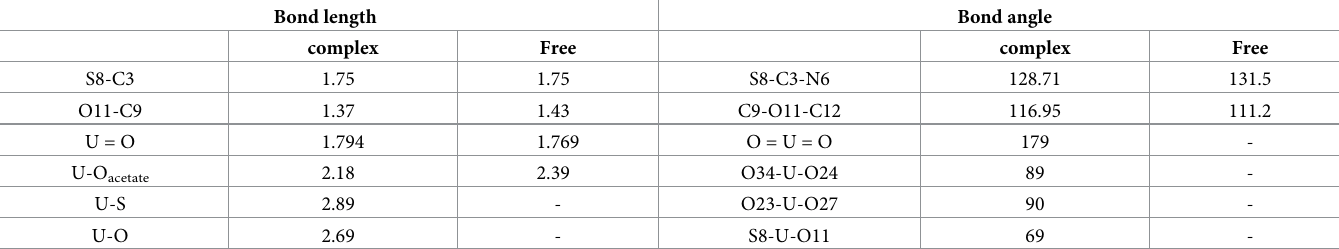
Table 3. Geometric ( Å , deg) comparison of free ligand/ uranyl acetate and calculated structures for [(UO 2 )(OAc) 2 (CMZ)].